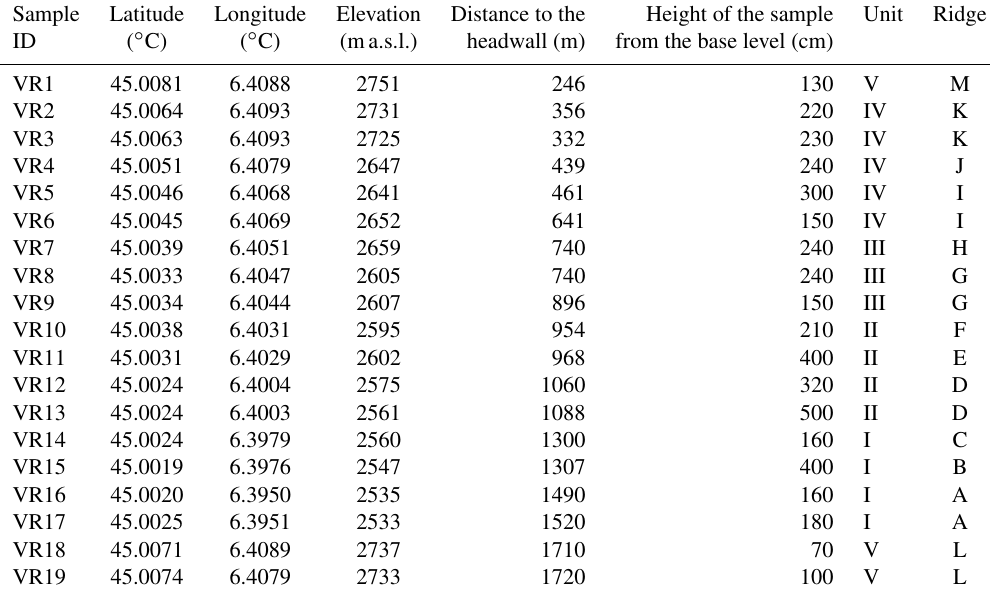
Table 1. Geographic details within the rock glacier system of the Vallon de la Route (Combeynot Massif, France) of the samples collected for 10 Be surface-exposure dating. Units represent areas of the rock glacier that have been defined geomorphologically. Ridges are also indicated (Fig. 3); for six of the ridges, two replicate boulders have been sampled. Ridge codes go from A at the lowest elevation to M at the highest elevation. The distance to the headwall has been measured following the center line of the rock glacier starting at the foot of the headwall (red line in Figs. 3 and